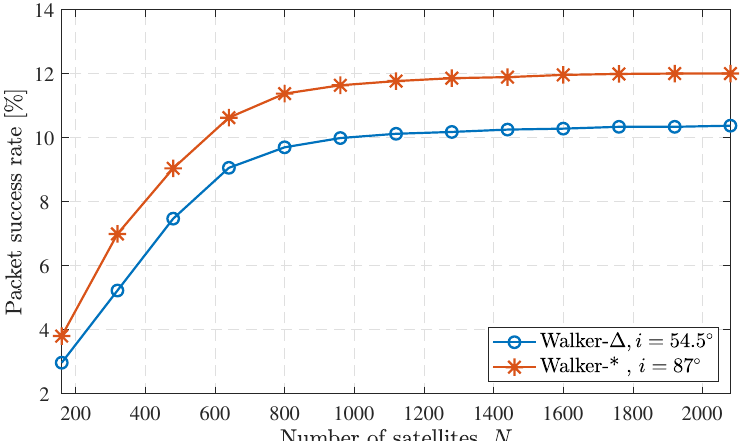
Figure 11. The packet successful rate for case I as a function of the number of satellites in the constellation. The IoT devices transmit power is P t = 27